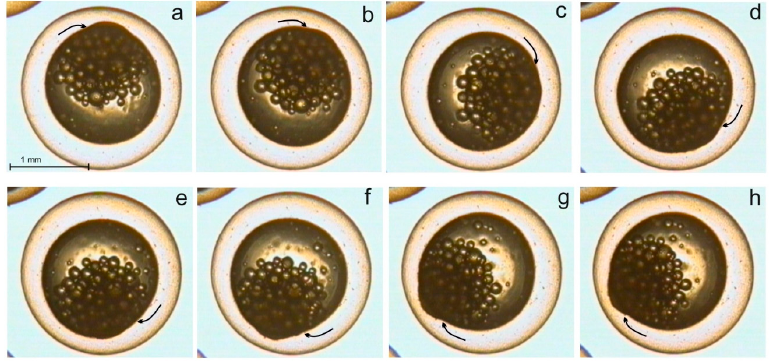
Figure 2. A quasiperistaltic wave moving at 1 min intervals ( a – h ) over the ectoplasm surface in the egg of European whitefish in a 4 mT SMF (top view, blastula stage)